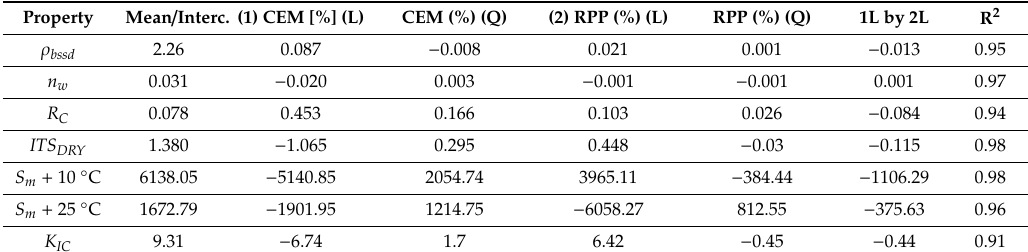
Table 15. Experimental coe ffi cients for the variables under